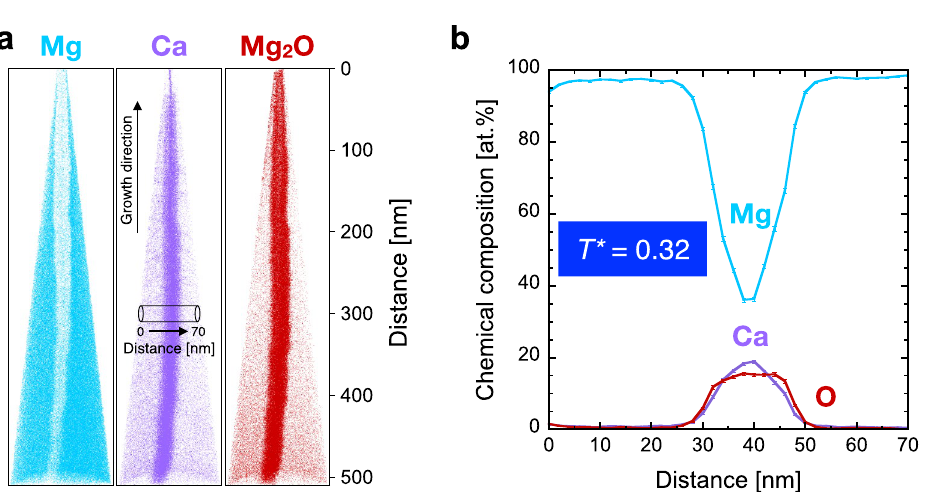
Figure 4. Three-dimensional chemical composition characterisation at the nanometre scale of the (Mg,Ca) solid solution thin film grown at T* = 0.32. ( a ) Reconstruction of detected Mg and Ca ions as well as Mg 2 O molecular ions. The cylinder with a length of 70 nm indicates the region from the chemical composition profile which is presented in ( b ). The corresponding mass spectrum and applied ranging as well as atomic positions of O can be found Fig. SI3, Table SI1 and Fig. SI4, respectively. Figure ( a ) was created with IVAS 3.8.0 (https:// www. atomp robe. com) and Fig. ( b ) was created with KaleidaGraph 4.5.3 (https:// www. syner gy.